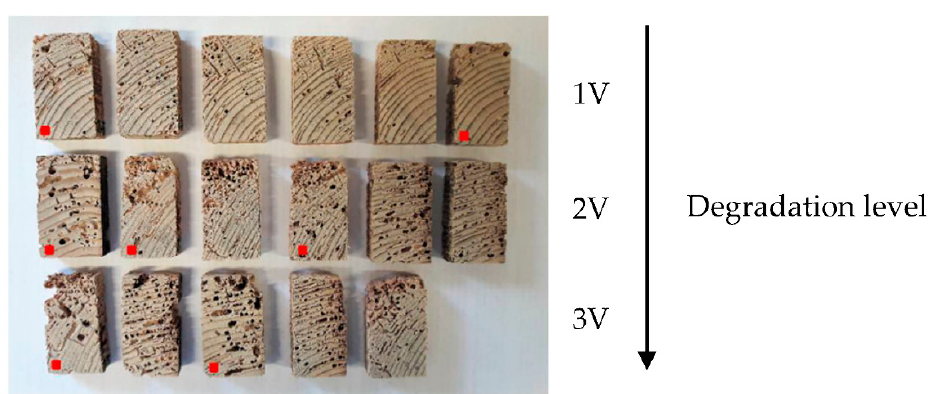
Figure 2. Sample preparation: 17 varying degrees of infested samples to be analyzed in µ -XCT were visually divided into 3 levels of degradation (all samples that were redistributed to a different level after μ -XCT results are marked in red). Average size of samples = 40 × 20 × 10 mm 3 .